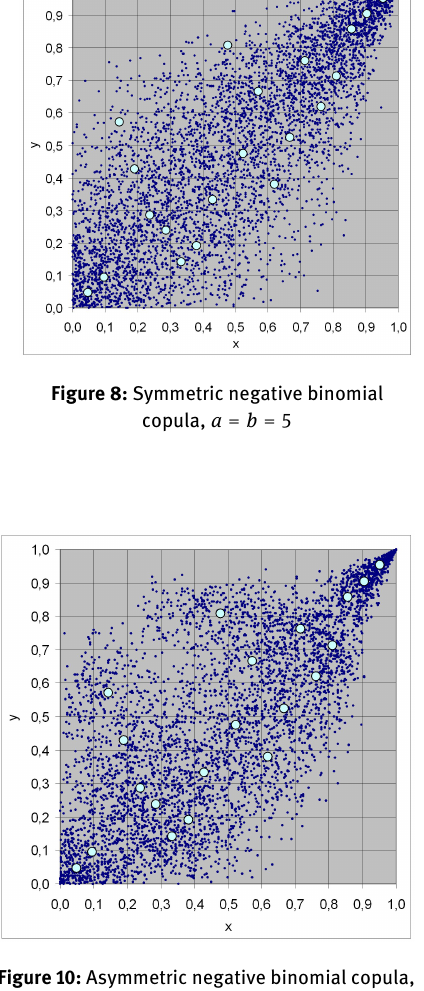
Figure 9: Asymmetric negative binomial copula, Figure 10: Asymmetric negative binomial copula,